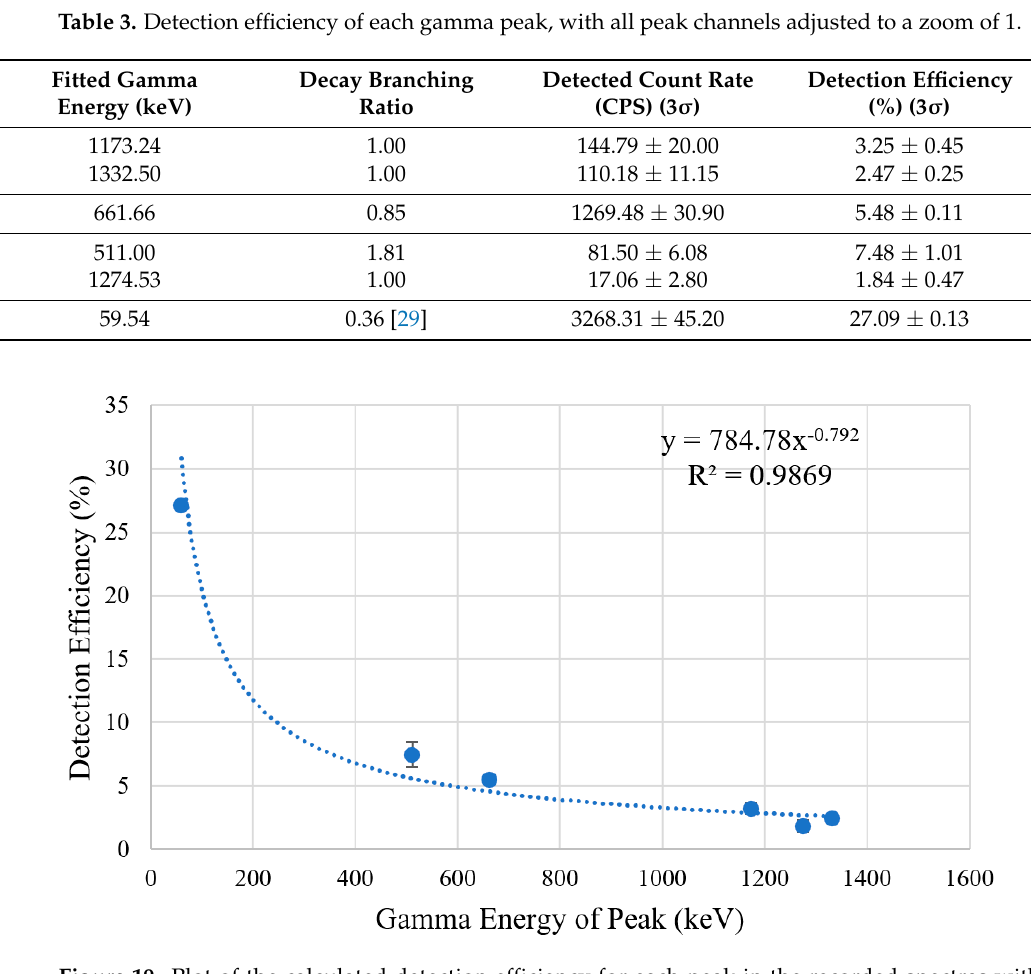
Figure 19. Plot of the calculated detection efficiency for each peak in the recorded spectras with three-sigma error bars. A power trend line has been added to the data alongside the R 2 value for the fit.